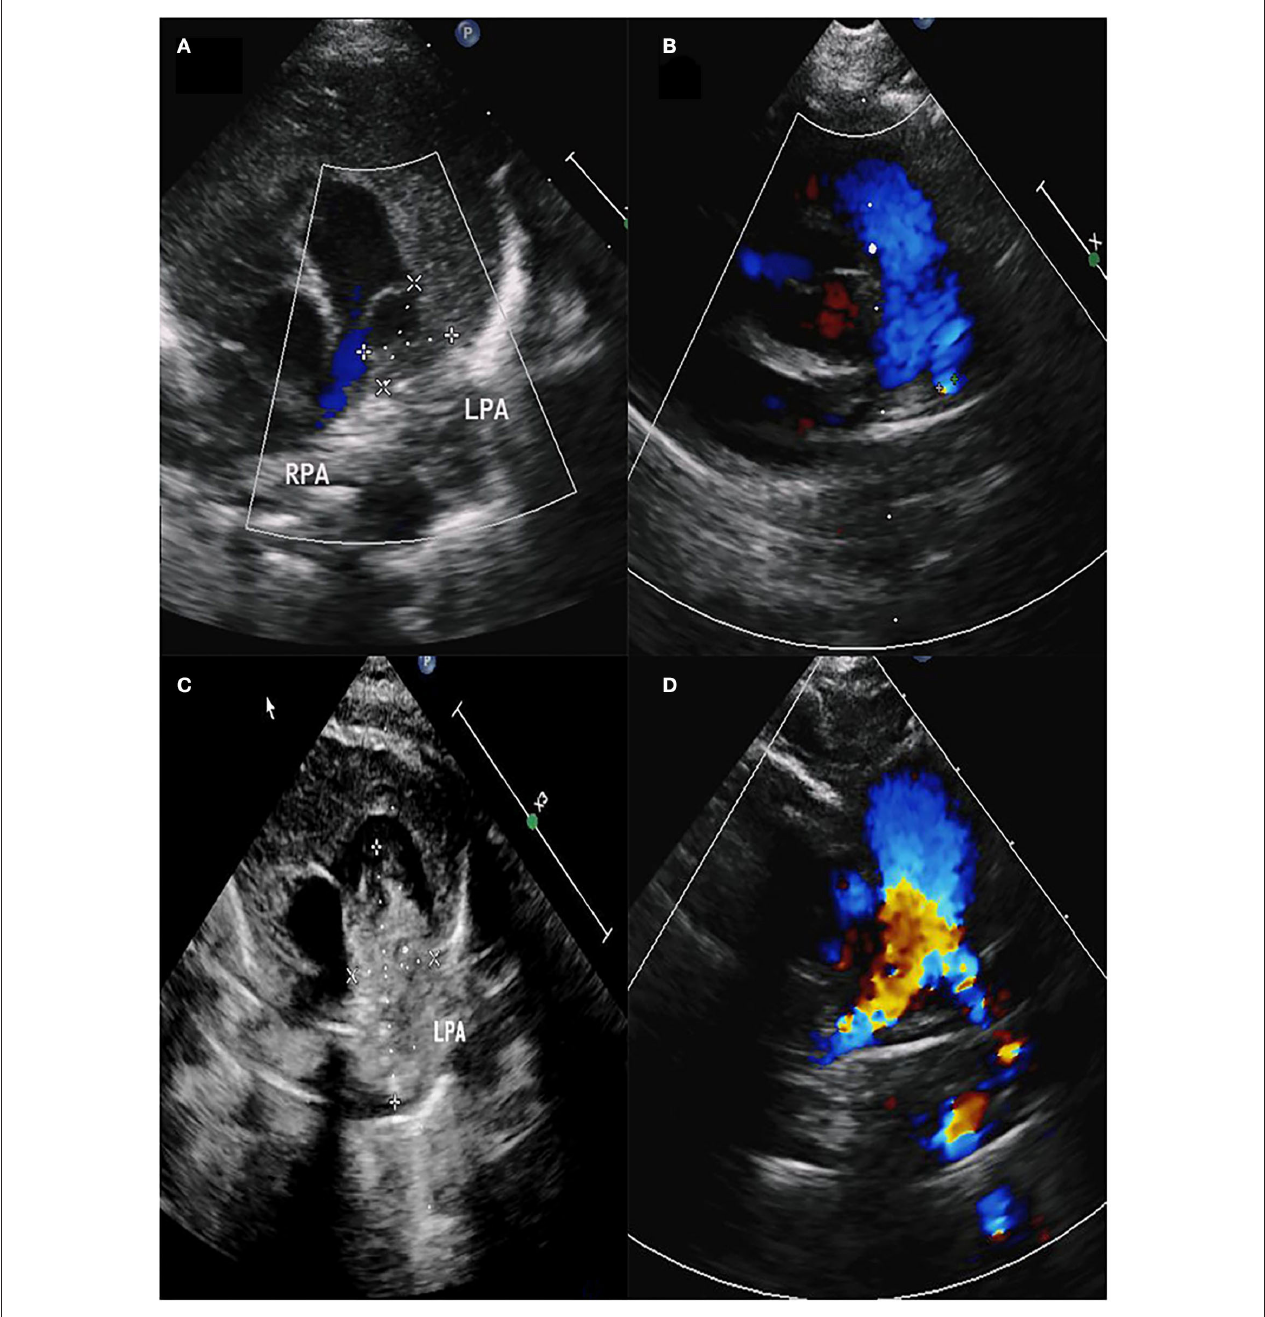
FIGURE 1 | (A) Space-occupying lesion with a size of 11.6 × 10.5mm in the pulmonary artery. (B) Diameter of the left pulmonary artery was 2.2mm. (C) Space-occupying lesion with a size of 31.9 × 15.7mm in the pulmonary artery. (D) Diameter of the left pulmonary artery was 3.9 mm.